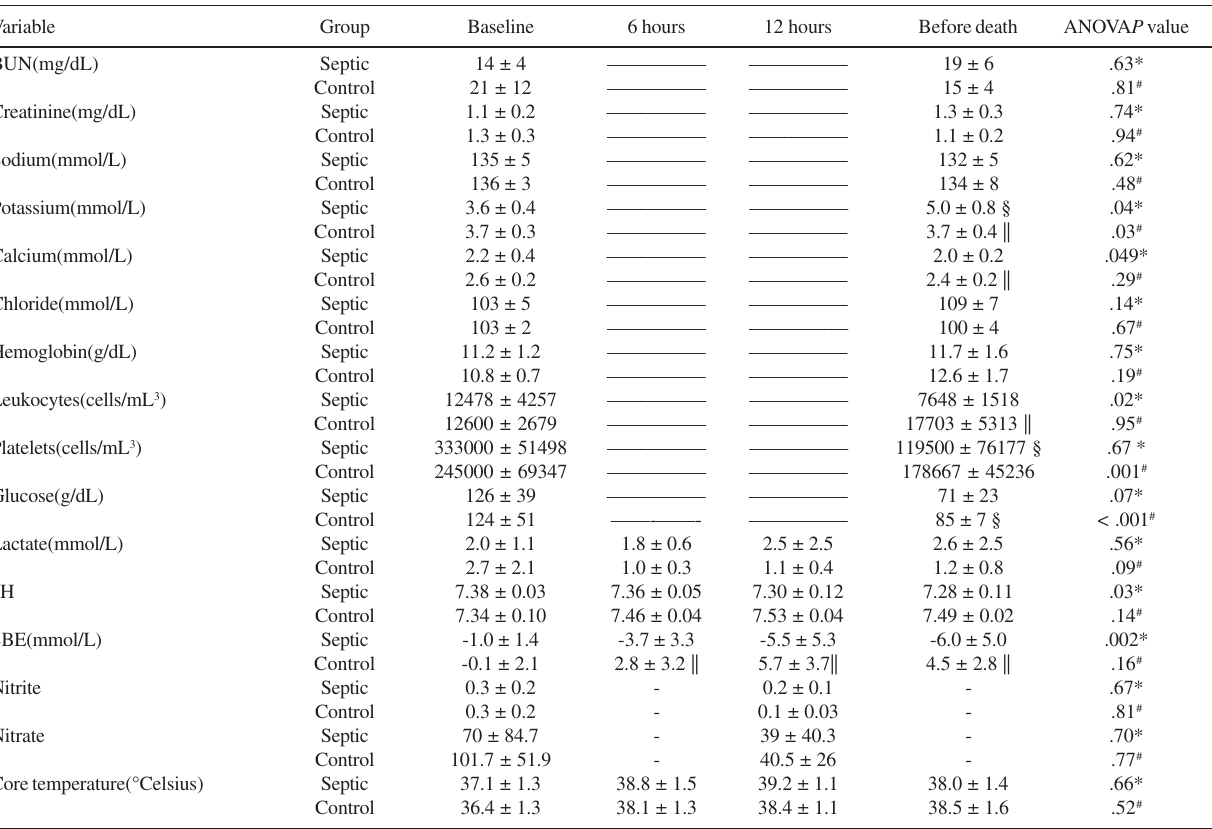
Table 3 - Laboratory data from septic and control groups